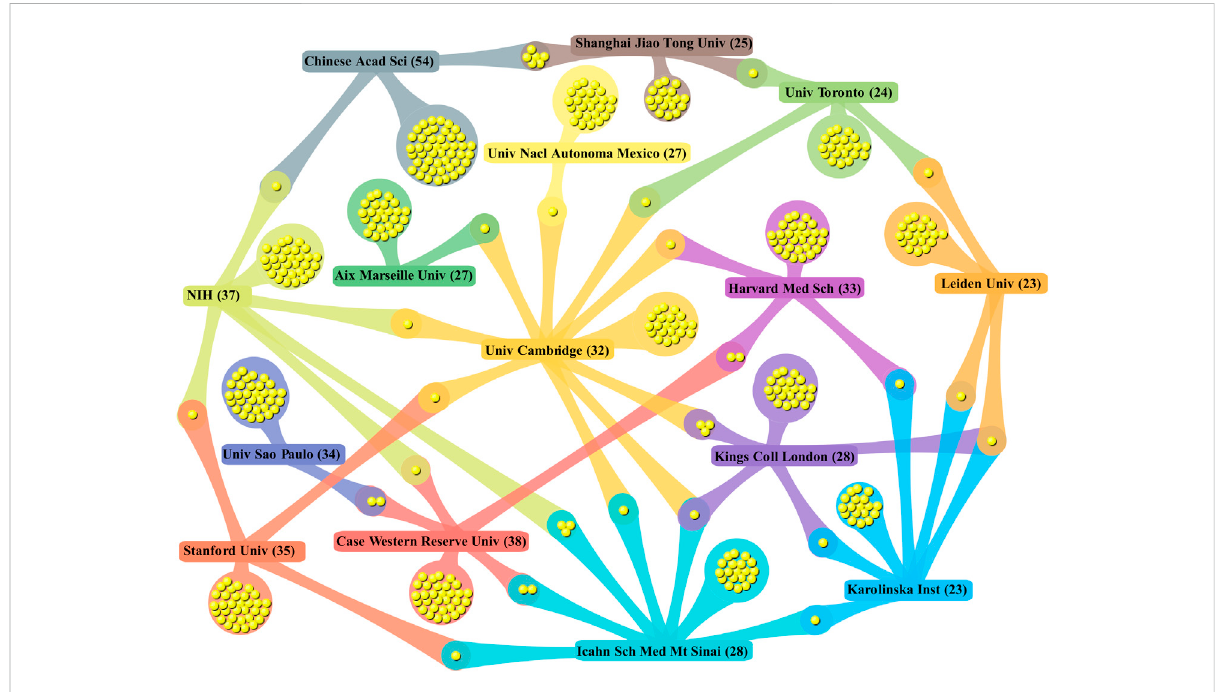
FIGURE 4 Collaboration matrix mapped between the fi rst 15 productive